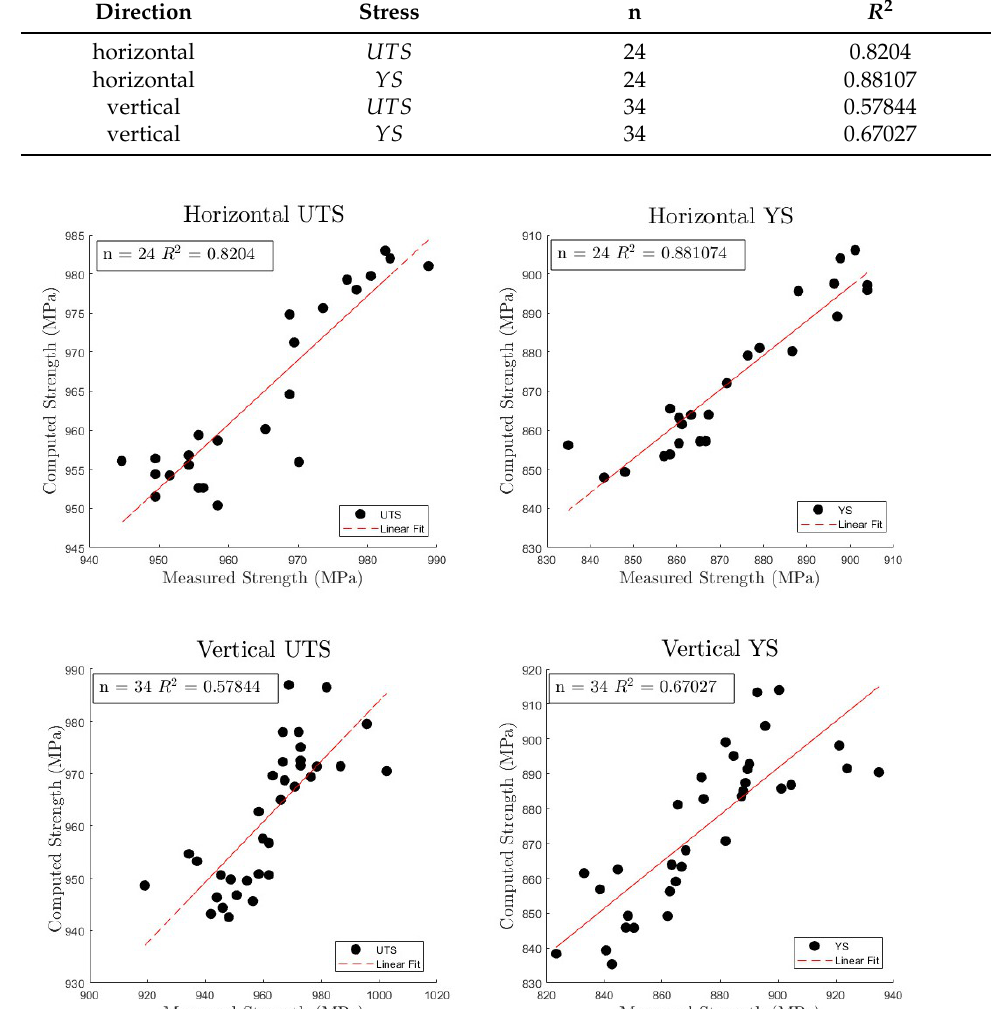
Table 8. The number of points in the NP2 data set, n , for the linear regression model and their associated correlation coefficient, R 2 .